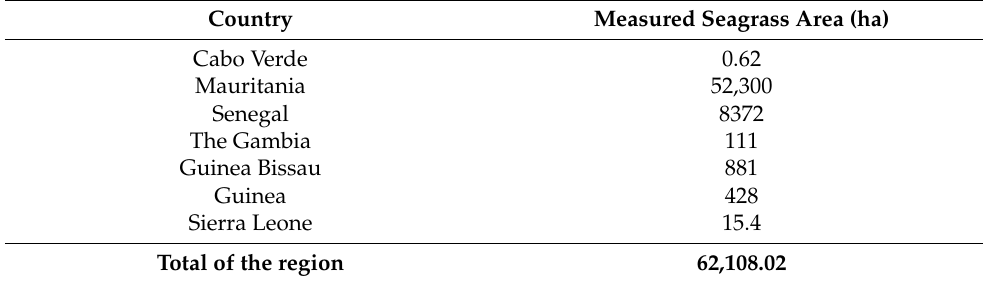
Table 3. Measured seagrass extent for each country; its confidence in the whole region.